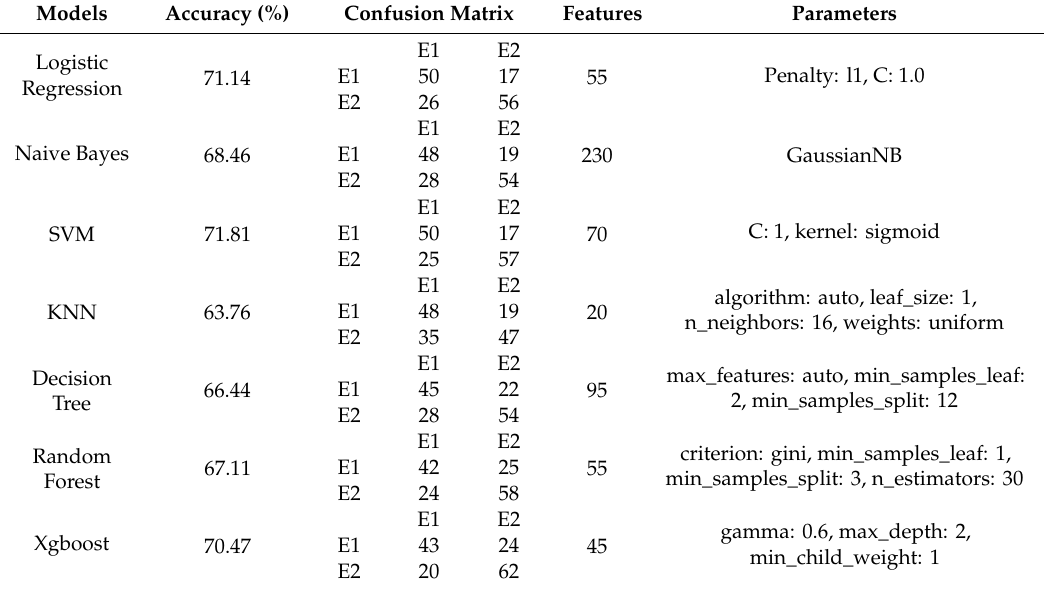
Figure 11. Learning curves with testing accuracy scores on dataset E for different ML models trained on feature subsets of increasing dimensionality. Table 8. Best testing accuracies achieved for each ML model along with the confusion matrix, the optimum number of features and the hyperparameters of the ML models employed. E1 and E2 denote classes 1 and 2 of dataset E, respectively.